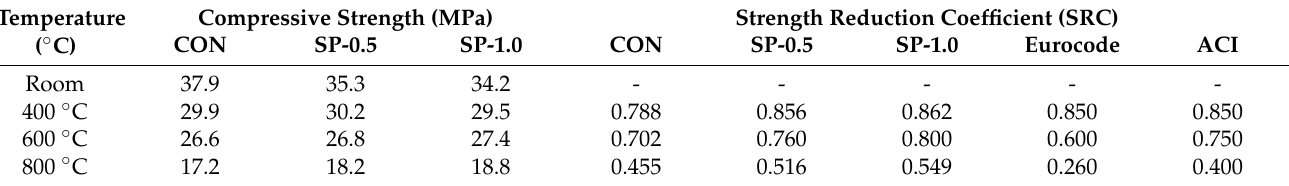
Table 6. Compressive strength of bare specimens after being exposed to